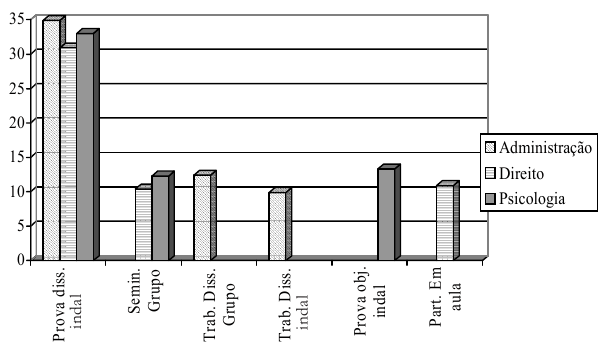
Figura 1. Distribuição do percentual de freqüência de opções por curso dos tipos de avaliação mais utilizados pelos